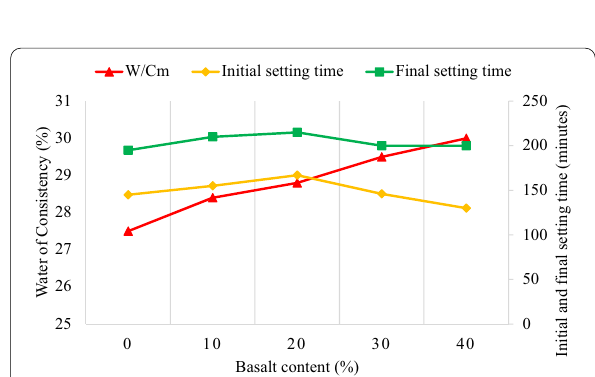
Fig. 3 Water of consistency, initial and final setting time of PPC and basaltic crusher dust.